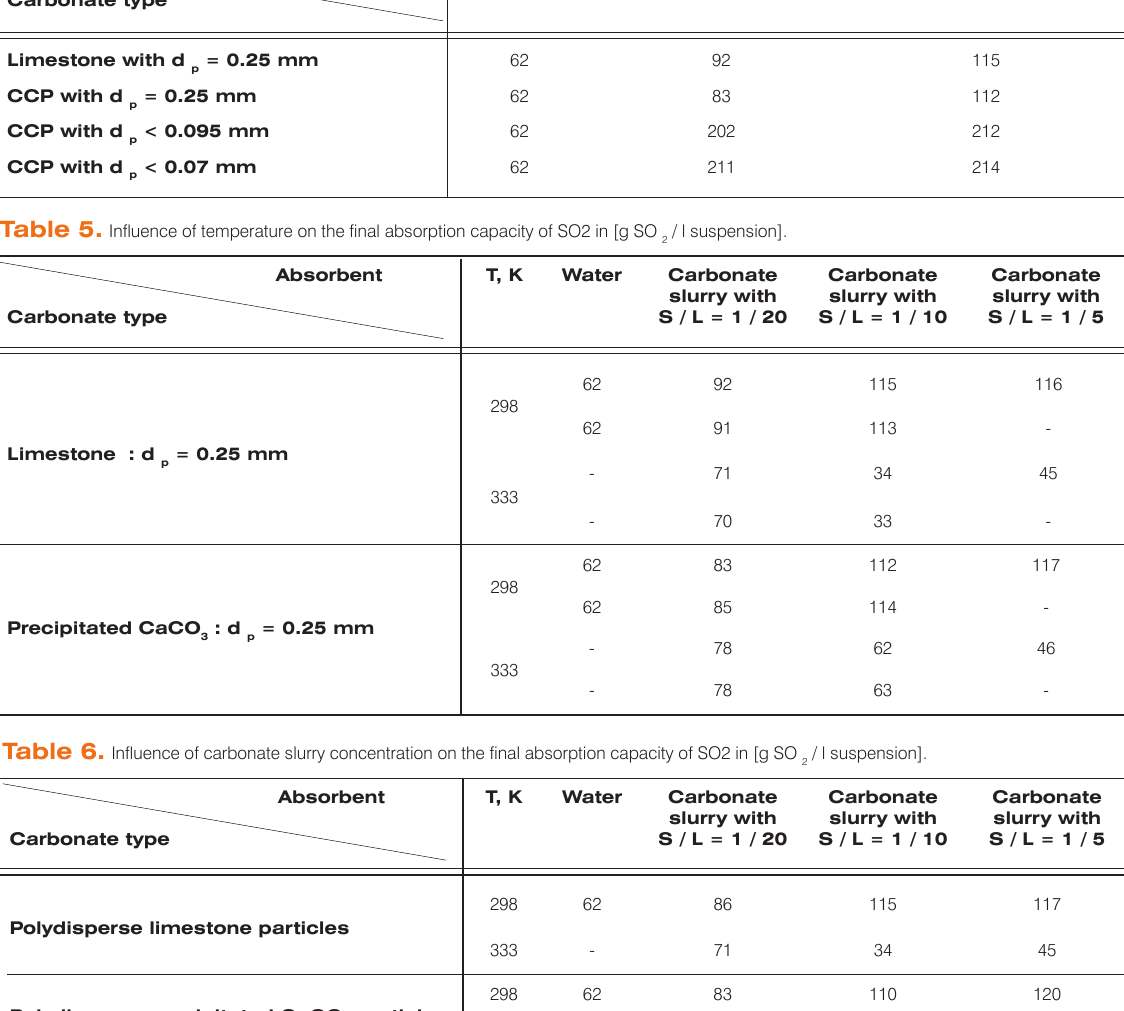
Table 4. Influence of the solid grain on the final absorption capacity of SO2 in [g SO